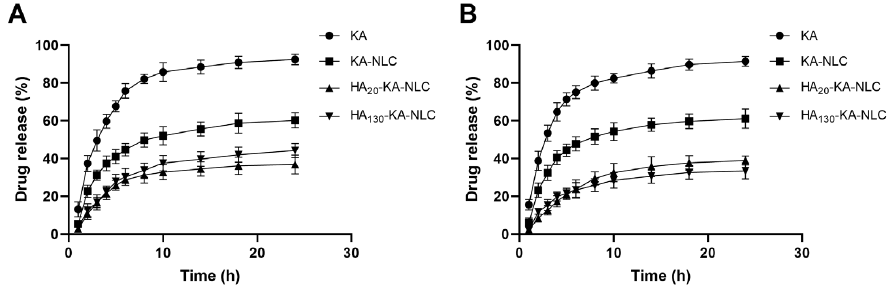
Figure 5. The in vitro drug release of preparations in ( A ) pH 5.5 and ( B ) pH 7.4.